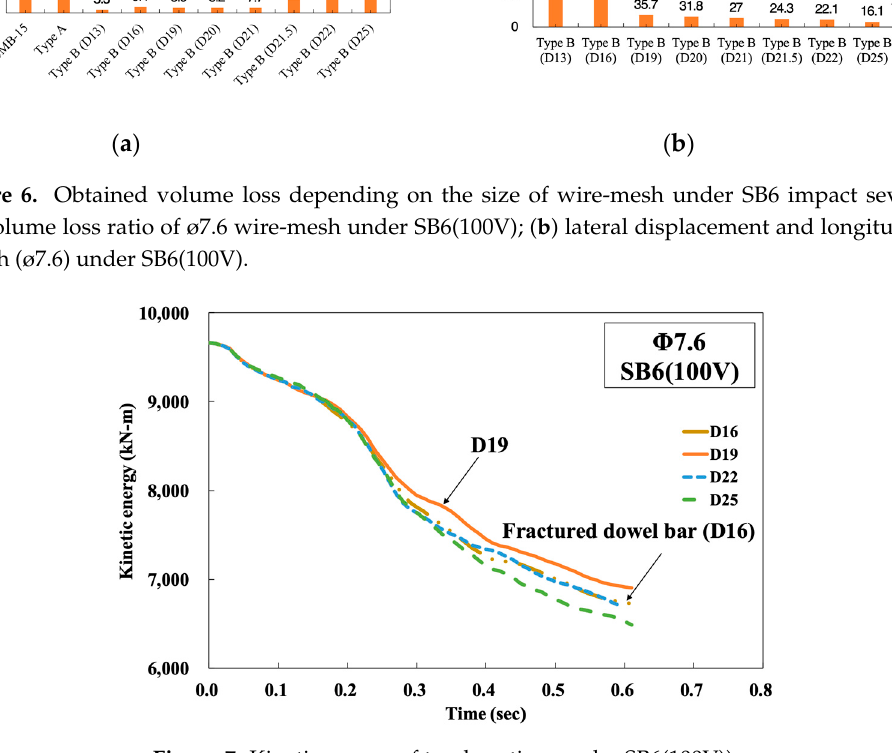
Figure 7. Kinetic energy of truck vs time under SB6(100V)).